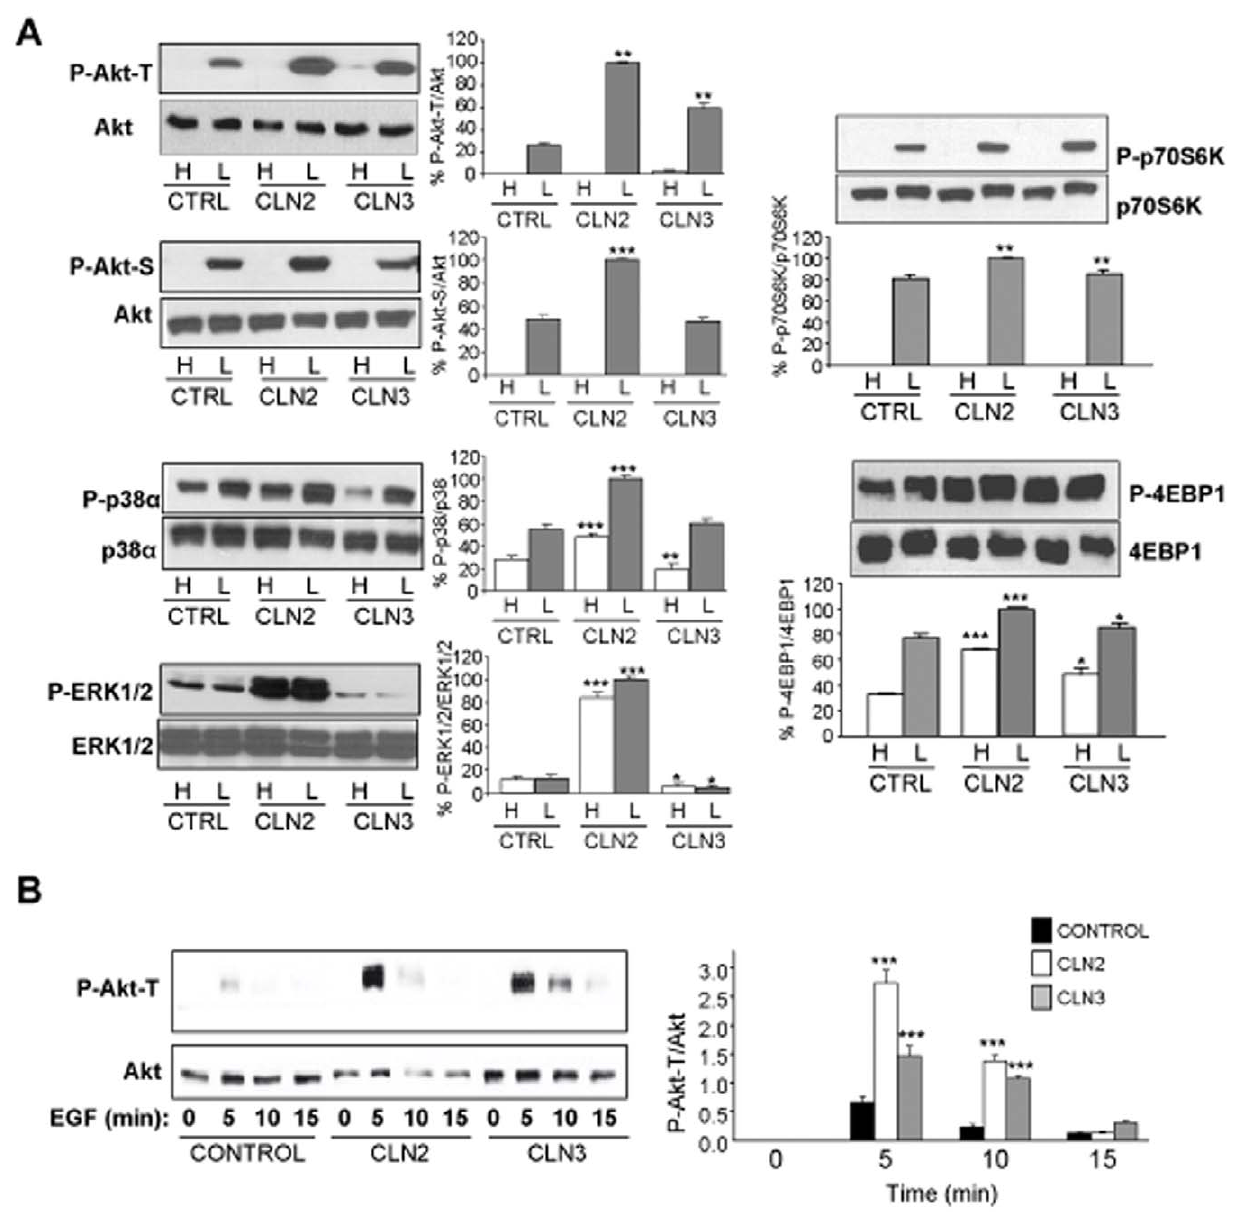
phosphorylated forms of various proteins upstream and downstream of mTOR: Akt-Thr 308 (P-Akt-T), Akt-Ser 473 (P-Akt-S), p-38 a (P-p38 a ), ERK 1/2 (P-ERK 1/2), p70S6K (P-p70S6K) and 4EBP1 (P-4EBP1) and their respective total proteins. The bands corresponding to the phosphorylated proteins, obtained from three different experiments, were densitometred and normalized to the corresponding bands of total protein. Data are plotted in percentage relative to the highest value. Stars indicate statistically significant differences from control values under high and low proteolysis conditions (*p , 0.05, **p , 0.01 and ***p , 0.005). (B) Control, CLN2 and CLN3 fibroblasts were incubated for the indicated times in high proteolysis medium with EGF (100 ng/ml). Total extracts were analyzed using P-Akt-T and total Akt antibodies. A representative blot is shown. The bands corresponding to phosphorylated and total Akt were quantified by densitometry as in A). Stars indicate statistically significant differences from control values at each time (***p ,